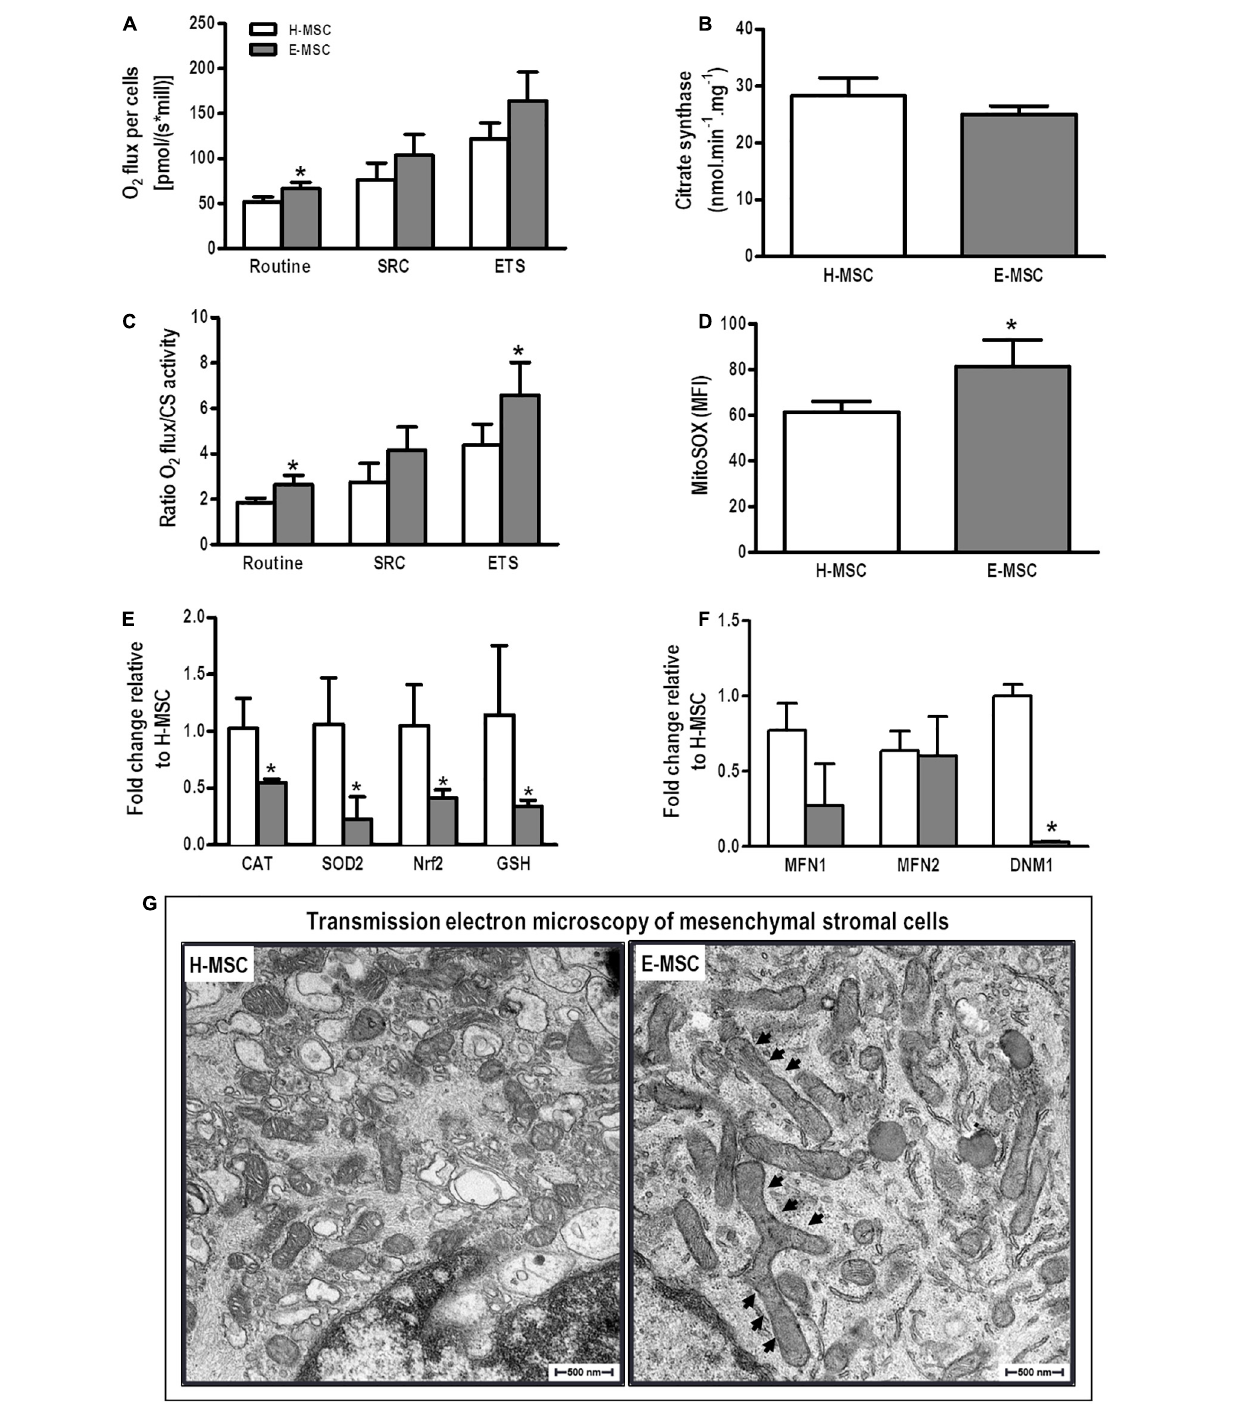
FIGURE 3 | Characterization of mitochondria of MSCs from healthy and emphysematous donors. (A) An OROBOROS system was used to measure basal (Routine), spare respiration capacity (SPC) and maximum (electron transfer system, ETS) mitochondrial respiration in H-MSCs and E-MSCs. (B) Citrate synthase was used as a quantitative enzyme marker for the presence of intact mitochondria in H-MSCs and E-MSCs. (C) Oxygraphy parameters were normalized by citrate synthase activity. (D) Mean fluorescence intensity detected by MitoSOX-based flow cytometry in H-MSCs and E-MSCs. Quantitative analysis of several antioxidant (E) and mitochondrial dynamics-related (F) genes in H-MSCs and E-MSCs by real-time RT-PCR. (G) Transmission electron microscopy to assess morphological features of mitochondria in H-MSCs and E-MSCs. Note mitochondrial elongation in E-MSCs (arrows). CAT, catalase; SOD2, superoxide dismutase 2; Nrf2, nuclear factor erythroid 2-related factor; GSH, glutathione; MFN1, mitofusin-1; MFN2, mitofusion-2; DNM1, dynamin-1. Data are expressed as means ± standard deviation of 5–6 samples in each group. * P < 0.05 vs. the H-MSC group.